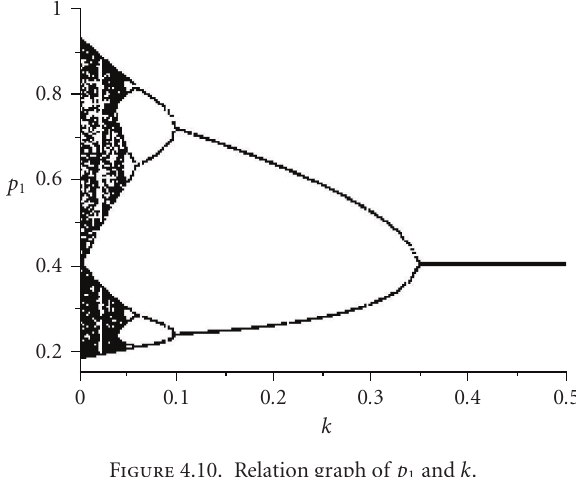
Figure 4.10 . Relation graph of p 1 and k .